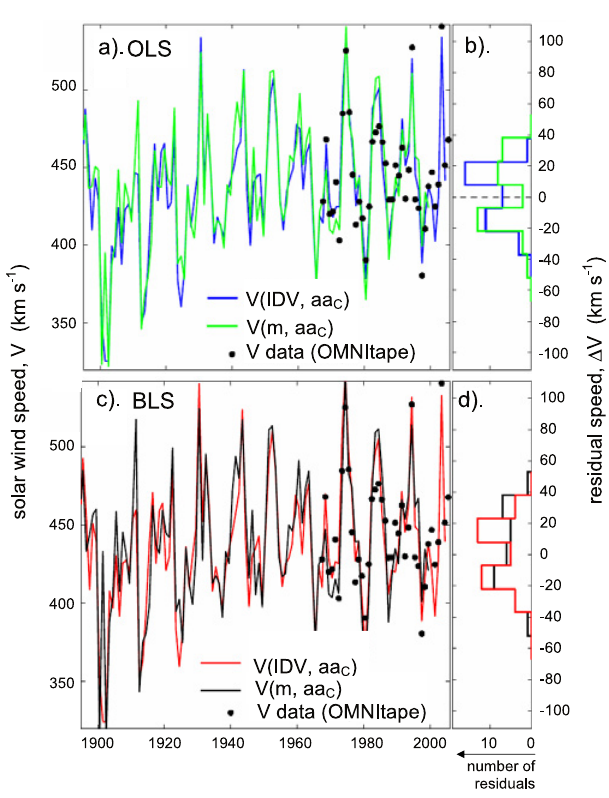
Figure 27: Reconstructions of annual means of the near-Earth solar wind speed 𝑉 SW from geomagnetic activity data. The upper panel is for ordinary least squares (OLS) regression, the lower panel for Bayesian least squares regression (BLS). Plots to the left are the time series, those to the right give the distribution of residuals of the fit to interplanetary in-situ observations. Blue and red lines are derived using 𝑎𝑎 𝐶 and 𝐼𝐷𝑉 whereas green and black are using 𝑎 𝐶 and 𝑚 . Solid circles show annual means of solar wind speed observations from the OMNI2 database. Image reproduced by permission from Rouillard et al. (2007), copyright by